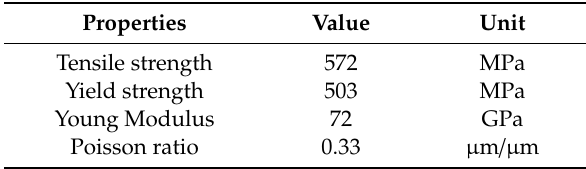
Table 1. Typical mechanical properties of the aluminum 7075-T6 [18].